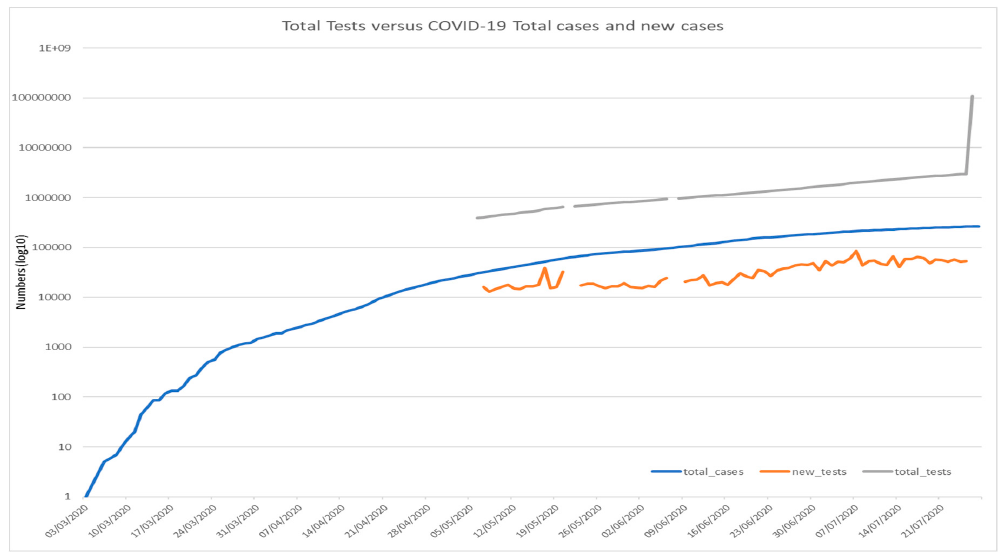
Figure 5. Cumulative tests performed against the daily COVID-19 confirmed new cases compared with cumulative cases recorded from March–July 2020 ( Using logarithmic scale based 10 ).